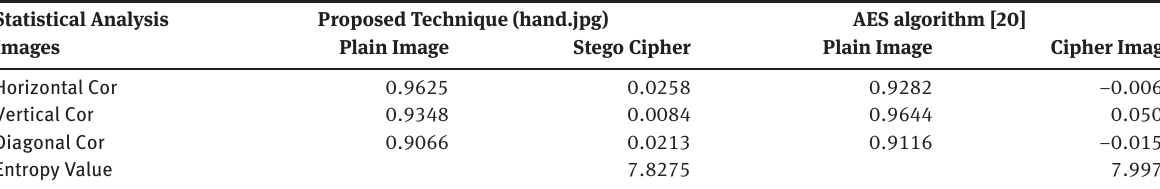
Table 7: Statistical Analysis of the Proposed Technique compared to AES